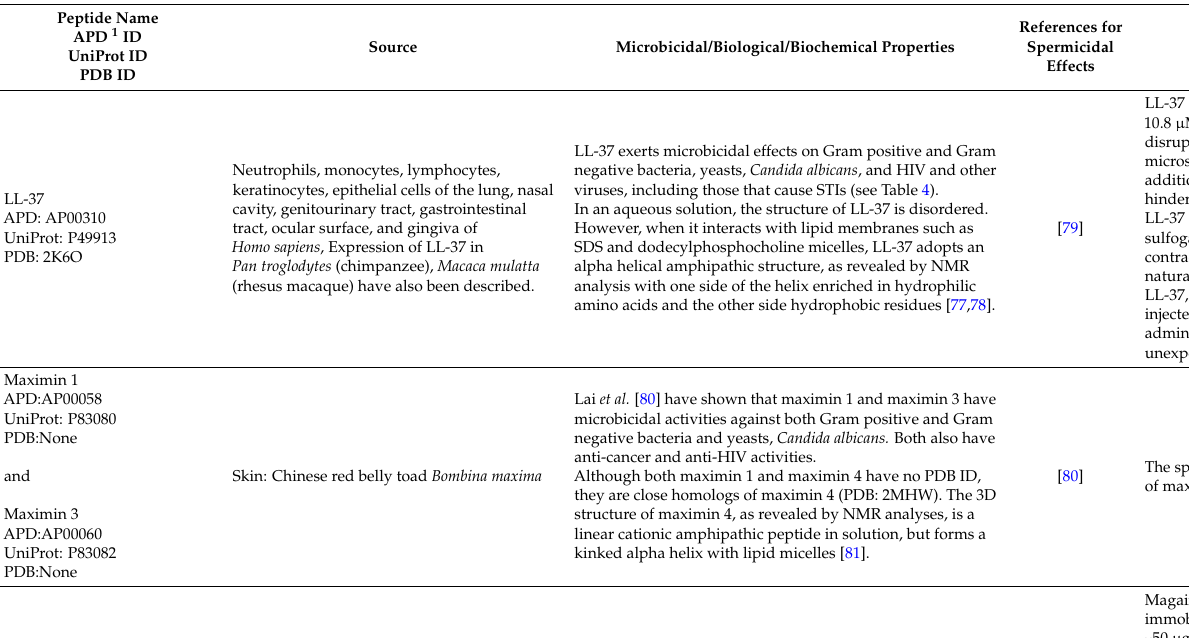
Table 2. Spermicidal antimicrobial peptides: microbicidal, structural and spermicidal